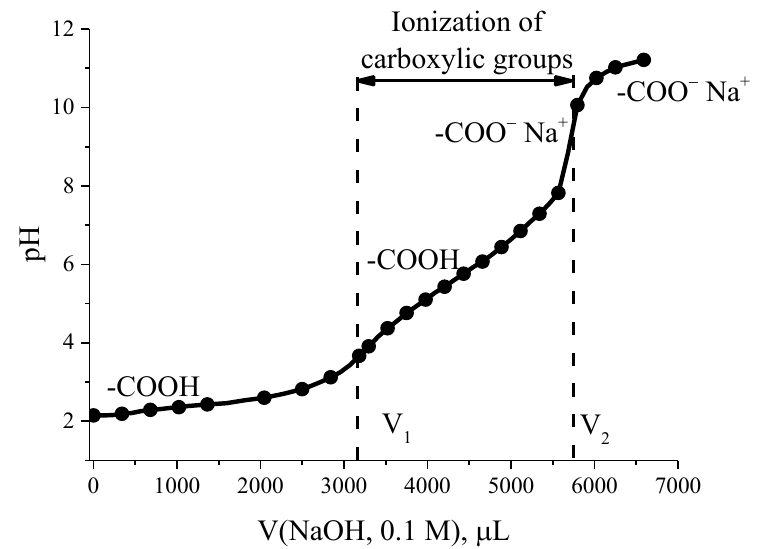
Figure 2. Potentiometric titration of 0.1 wt.% ACP# aqueous solution (50 mL) by 0.1 M NaOH aqueous solution. V 1 corresponds to titration of HCl excess, V 2 to titration of ACP# carboxylic groups (see details in the text).